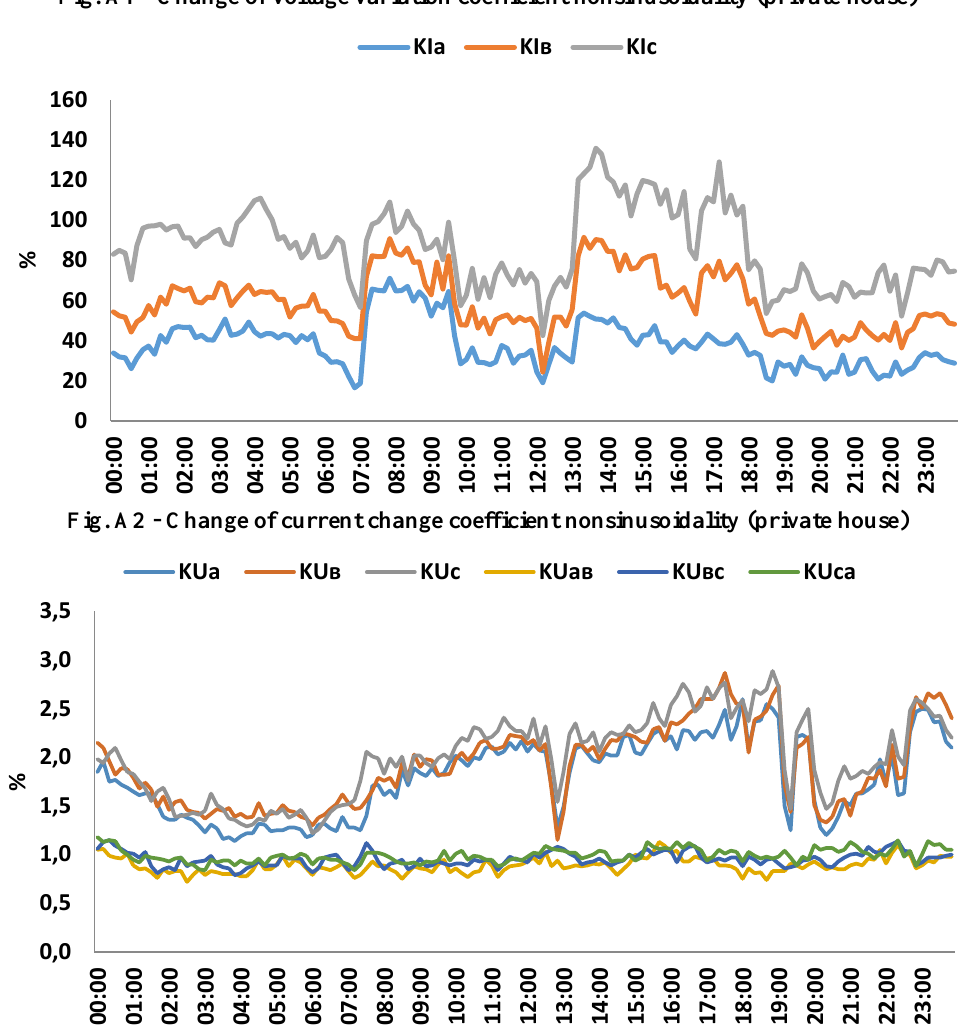
Fig. A3 - Change of coefficient non-sinusoidality of voltage (apartment